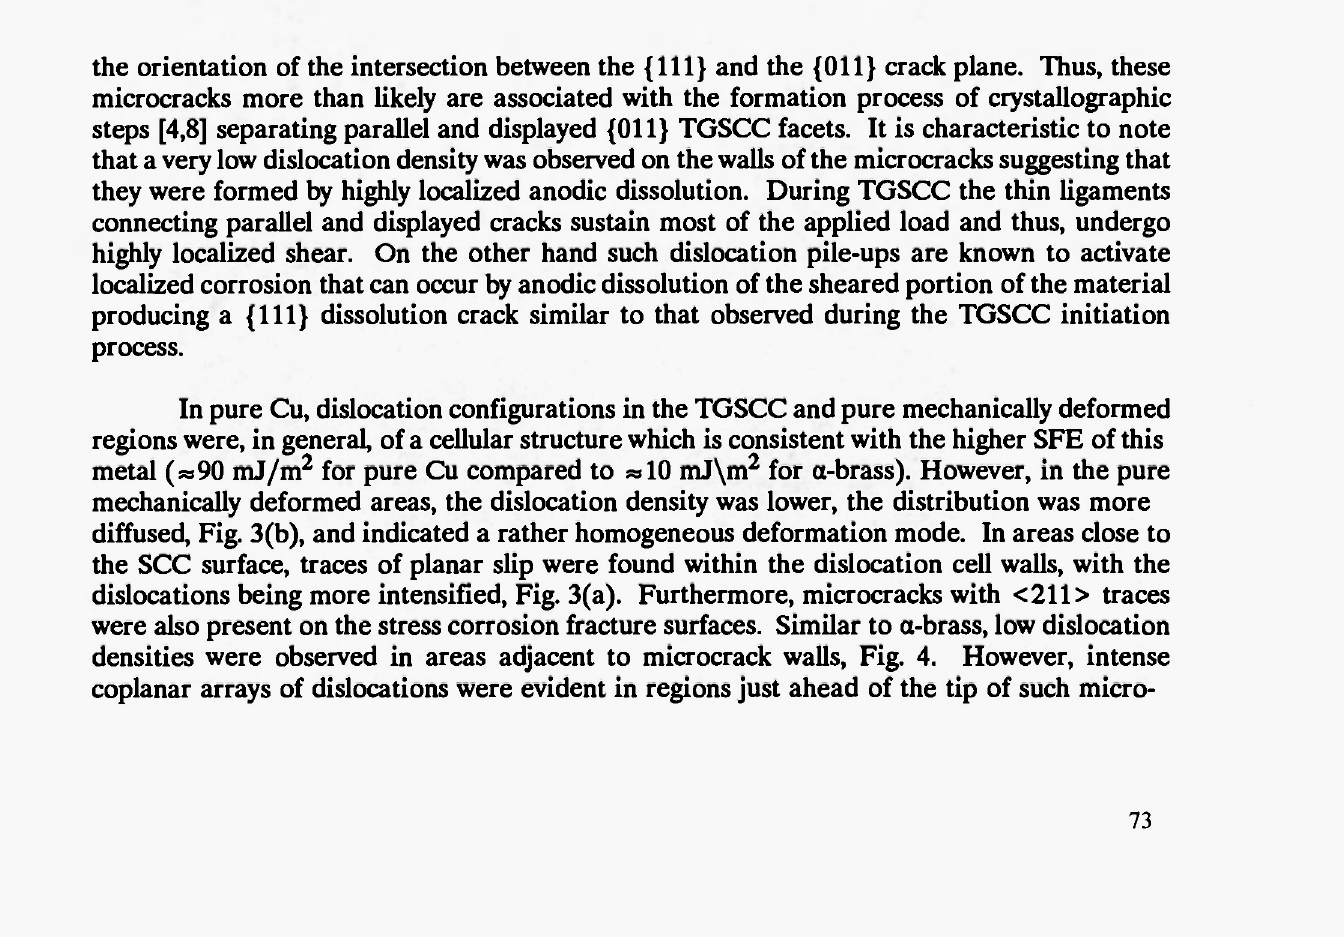
Fig. 2 A dissolution microcrack in α-brass following the <211 > direction (intersection of the {111} with the {011} crack